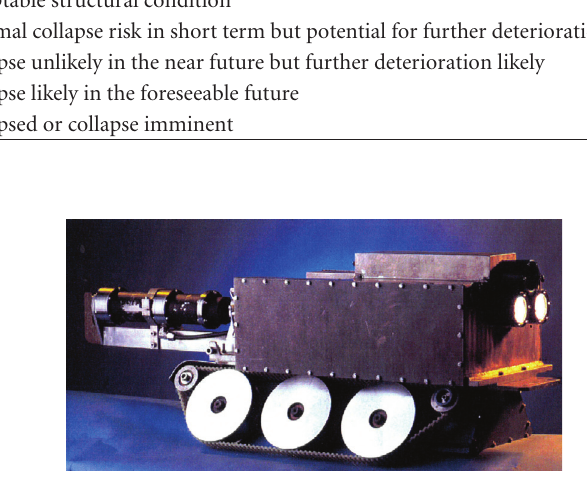
Figure 1: The PIRAT image acquisition